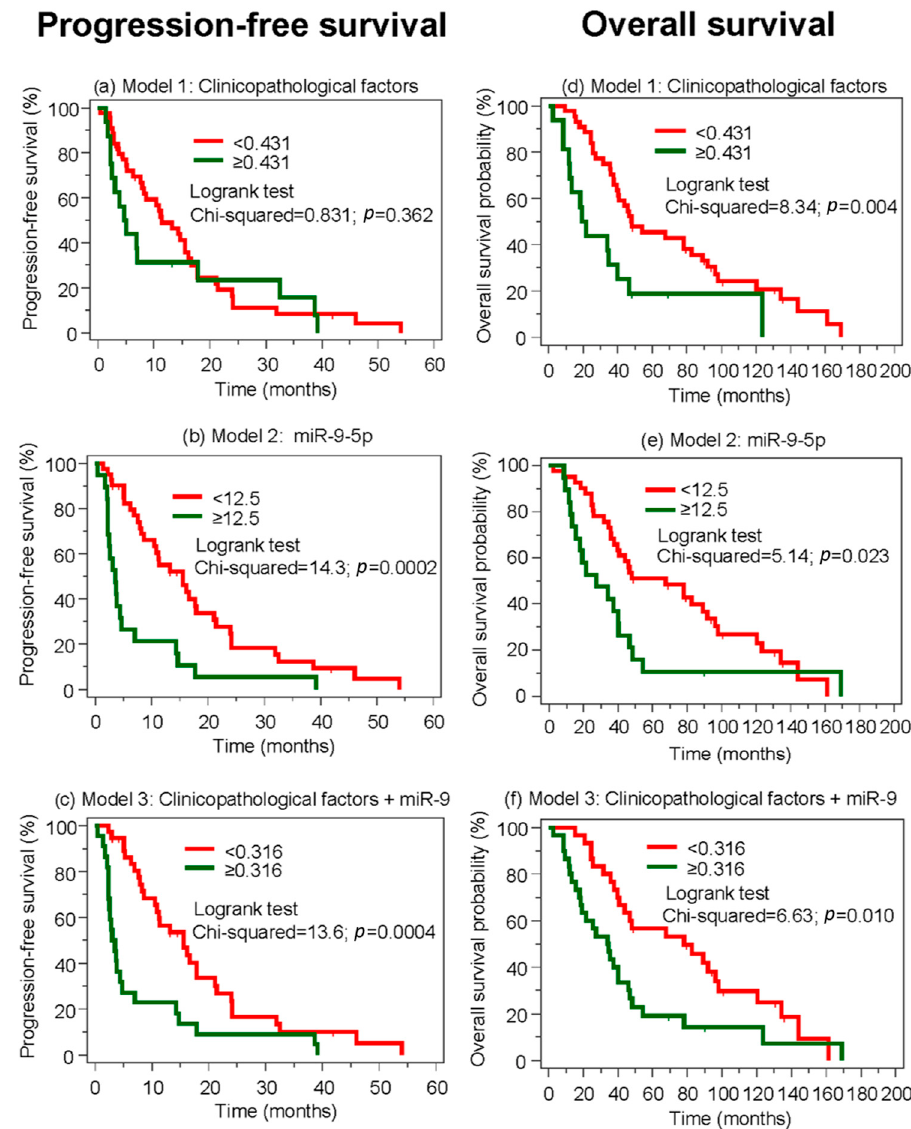
Figure 5. Kaplan-Meier curves of progression-free survival and overall survival based on the prediction models of primary resistance to the treatment with TKIs. The variables of the prediction models were used in the binary logistic regression analyses. Model 1 included the clinicopathological variables age, sex, tumor stage, Fuhrman grade, metastatic and resection status as indicated in Table 1; Model 2 considered only continuous miR-9-5p values; and Model 3 was a combination of the clinicopathological and miR-9-5p values. The propensity scores of logistic regression analyses as outputs of the predicted probabilities were used to calculate the best discriminatory cutoffs using the Youden index in ROC analysis. Based on these cutoffs indicated in the respective figures, the output data were dichotomized and the corresponding Kaplan-Meier curves for progression-free survival (left column, subfigures ( a – c )) and overall survival (right column, subfigures ( d – f )) were generated. TKI, tyrosine kinase inhibitors.